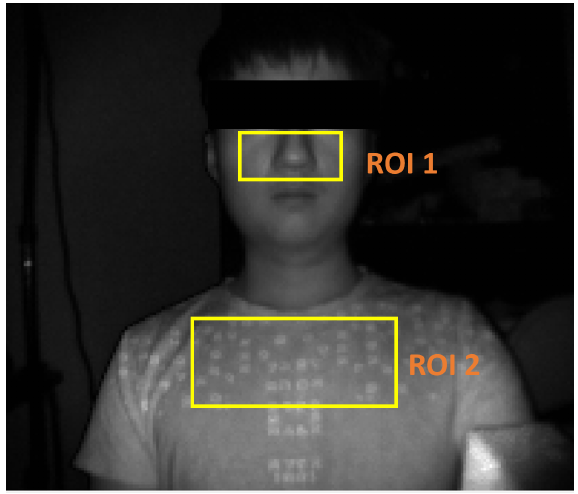
Figure 2. Two ROIs used for RR and HR extraction: ROI-1 is used for HR measurements while ROI-2 is used for RR measurements.